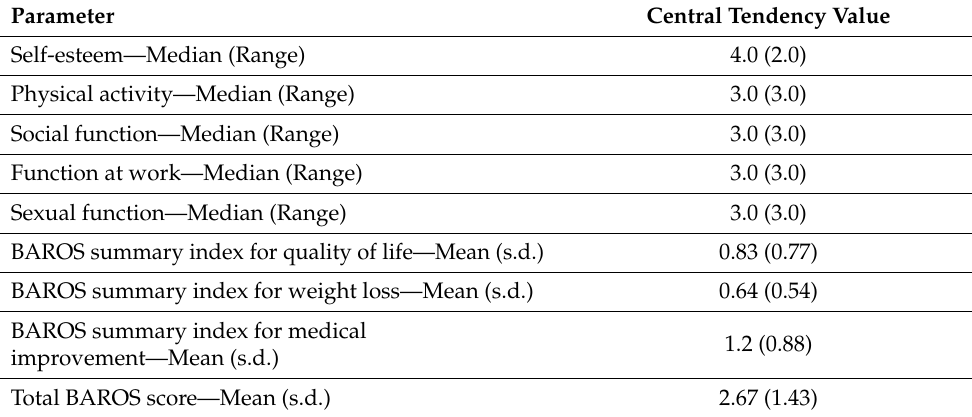
Table 2. The post-op quality of life